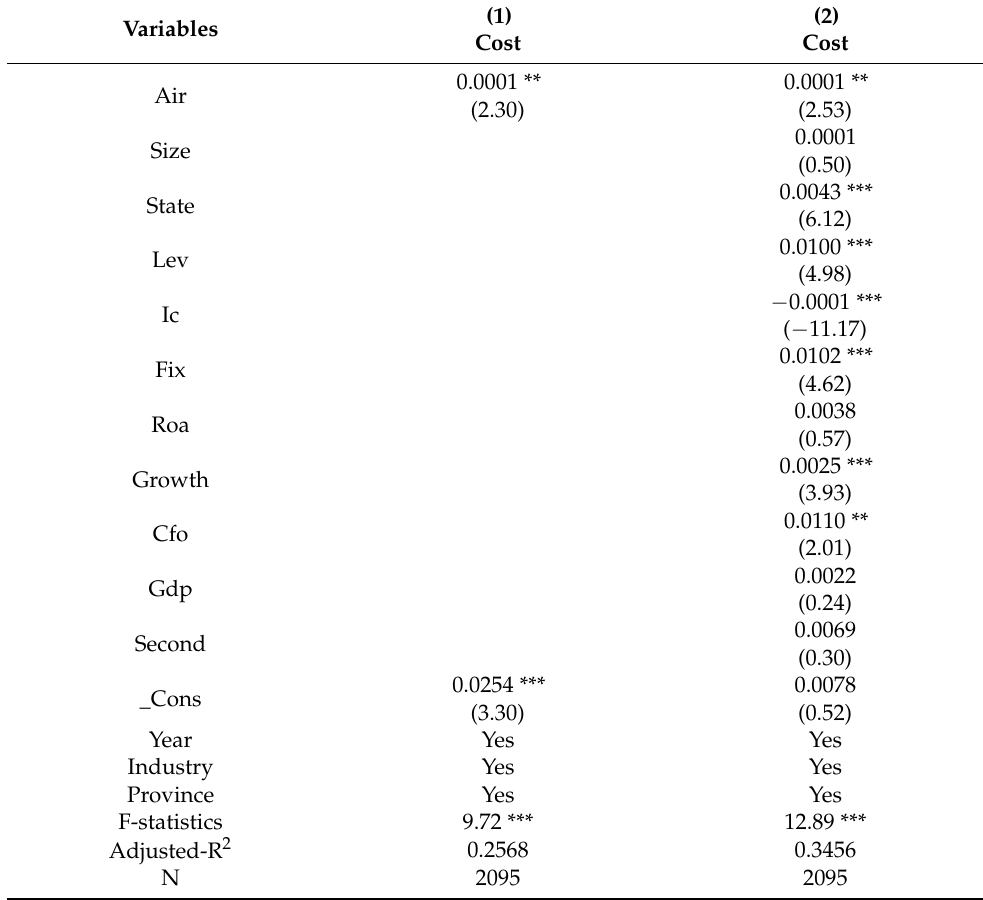
Table 10. Endogenous test of PSM